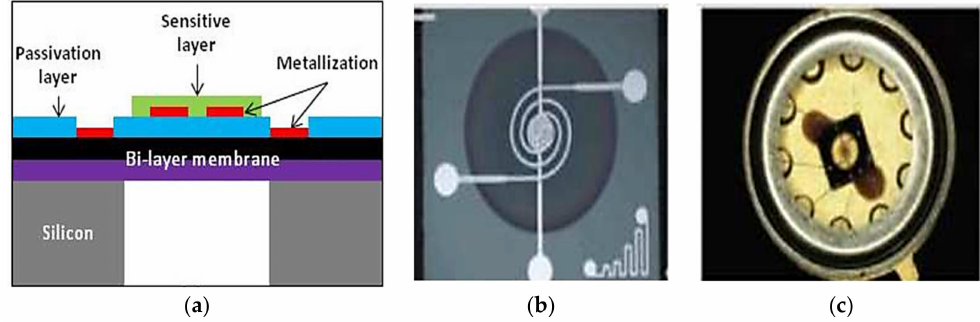
Figure 2. Micro-hotplate gas sensor: ( a ) cross sectional view, ( b ) chip top view, ( c ) chip packaged on a TO-5